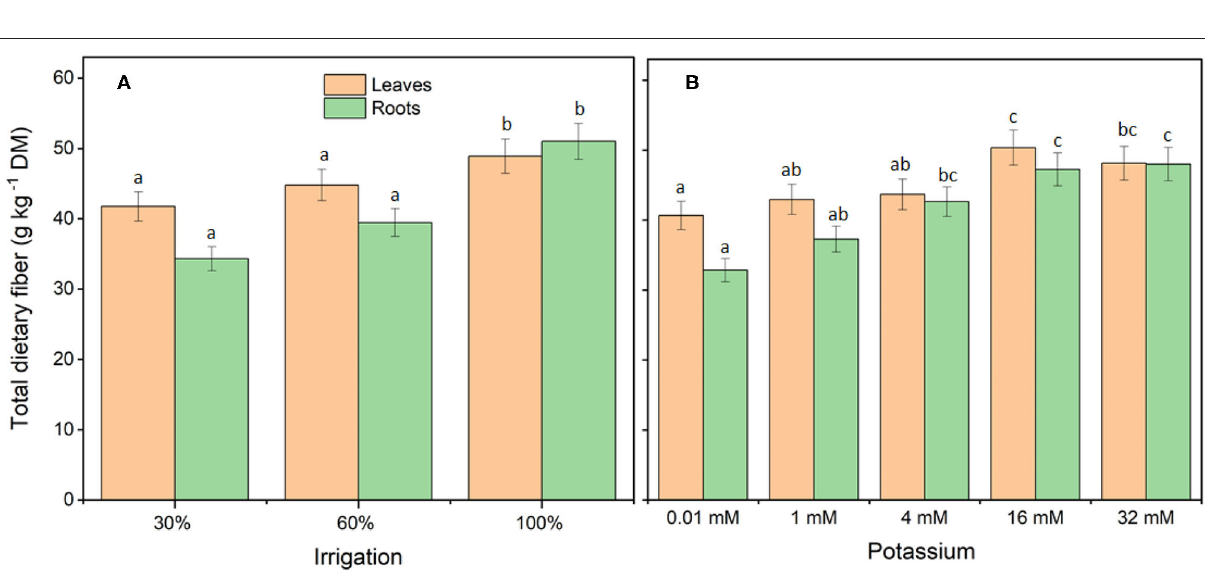
8%, when compared with full-irrigated plants. Compared